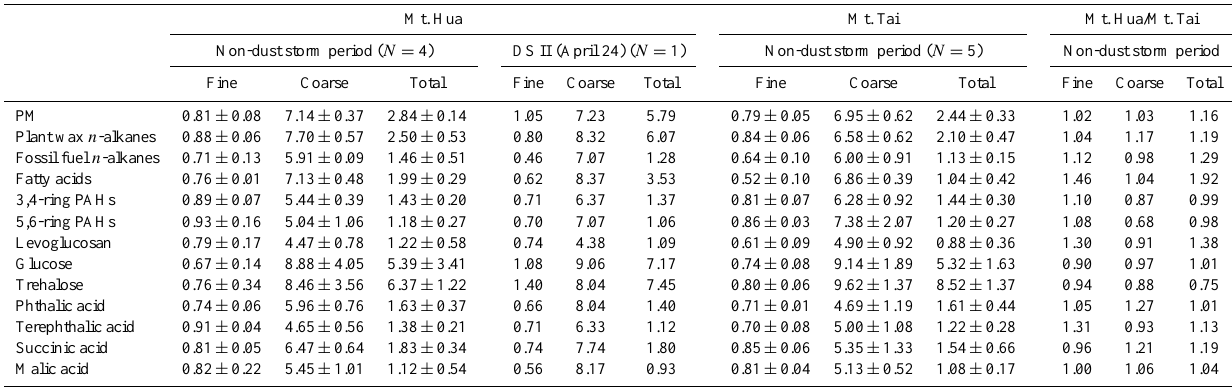
Table 4. Geometric mean diameters (GMD, µm) a of organic aerosols at Mt. Hua and Mt. Tai during the spring of 2009.